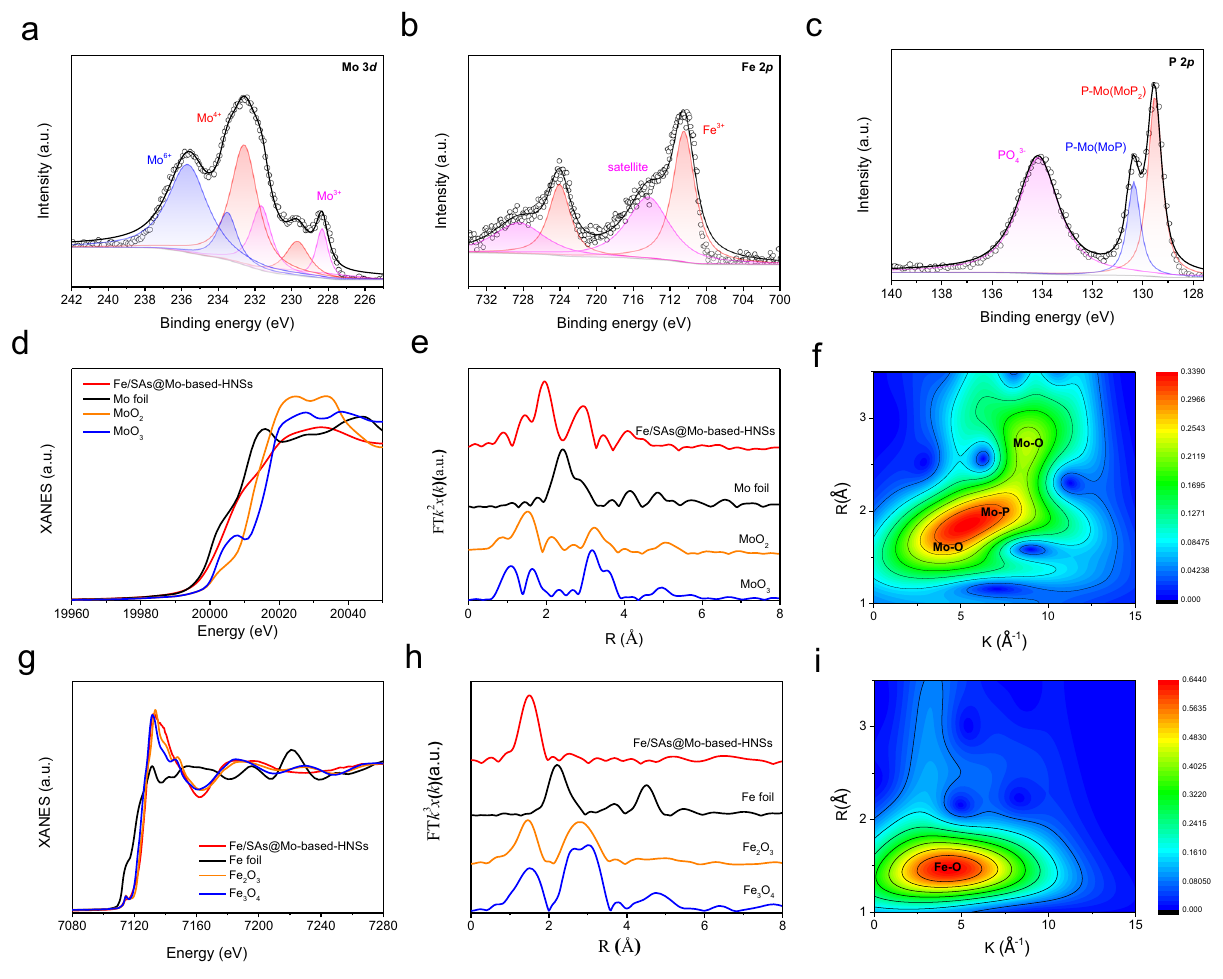
Fig. 3 | Spectroscopy of Fe/SAs@Mo-based-HNSs. a Mo 3 d XPS spectra; b Fe 2 p XPS spectra; c P 2 p XPS spectra; d Mo K-edge XANES spectra; e corresponding k 2 - weighted FT of EXAFS spectra; f wavelet transforms for k 2 -weighted EXAFS signals